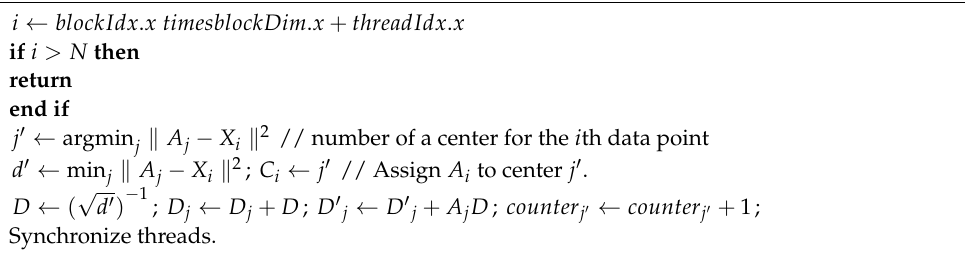
Algorithm 5 CUDA implementation of Step 1 in the ALA algorithm